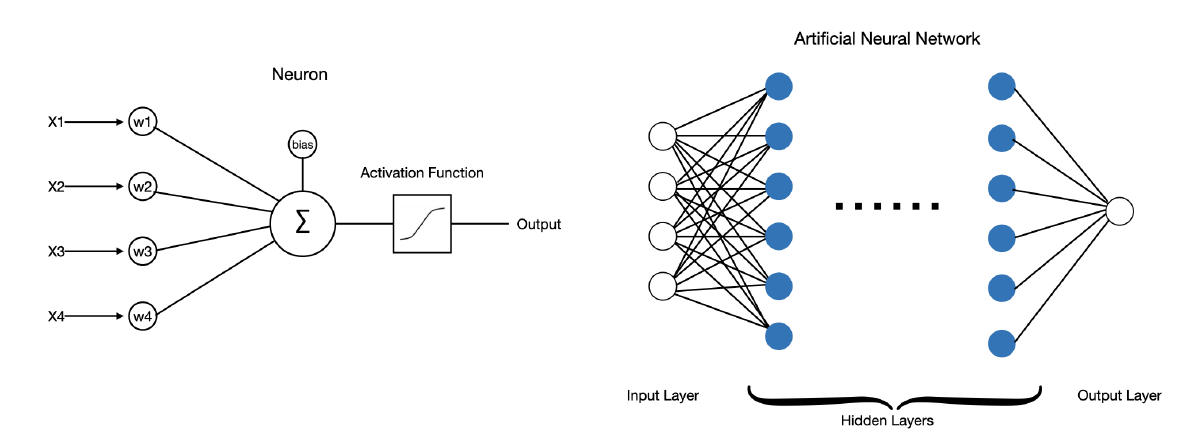
Figure 5. The left panel shows an example node in a neural network, where w i is the weights for each input x i , and the linear function produces bias + ∑ i x i w i that is passed to an activation function. The right panel shows an example of artificial neural network (ANN) with single output, where the blue nodes in hidden layers and the white node in the output layer are